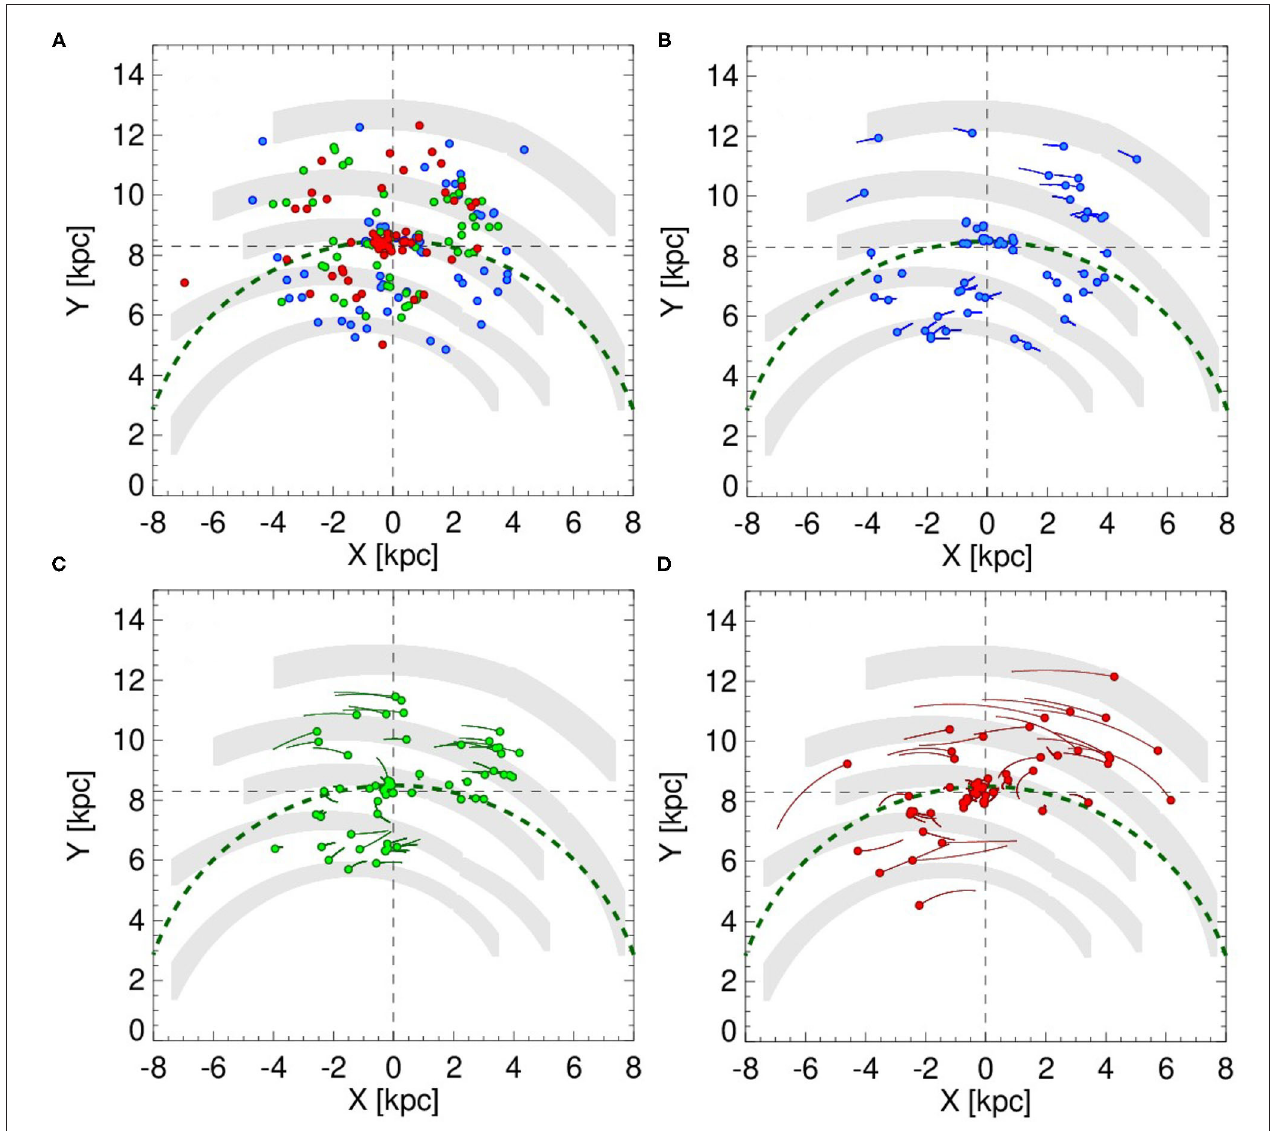
FIGURE 10 | Results of the backward integration of the orbits of open clusters younger than 50Myr [log(age) < 7.7]. The open clusters are separated in colors by the corresponding intervals of ages: blue for clusters with age < 11.5Myr; green for clusters with 11.5 < age < 23.5Myr; and red for clusters with age > 23.5Myr. The green dashed circle represents the corotation circle. The gray shaded areas show segments of the spiral arms from Reid et al. (2019), which are, from top to down, respectively, the Outer arm, the Perseus arm, the Local arm, the Sagittarius-Carina arm, and the Scutum-Centaurus arm. The integration of the orbits was done in the reference frame of the spiral pattern with angular velocity (cid:127) p = 28.5kms − 1 kpc − 1 . (A) Shows the present-day positions of the open clusters on the Galactic plane. (B) Shows the birthplaces of the open clusters younger than 11.5Myr (filled circles), with the tracing of the orbits since their present-day positions. (C,D) Are the same of (B) but for the birthplaces and orbits of the open clusters in the age intervals of 11.5 < age < 23.5Myr and age > 23.5Myr, respectively.